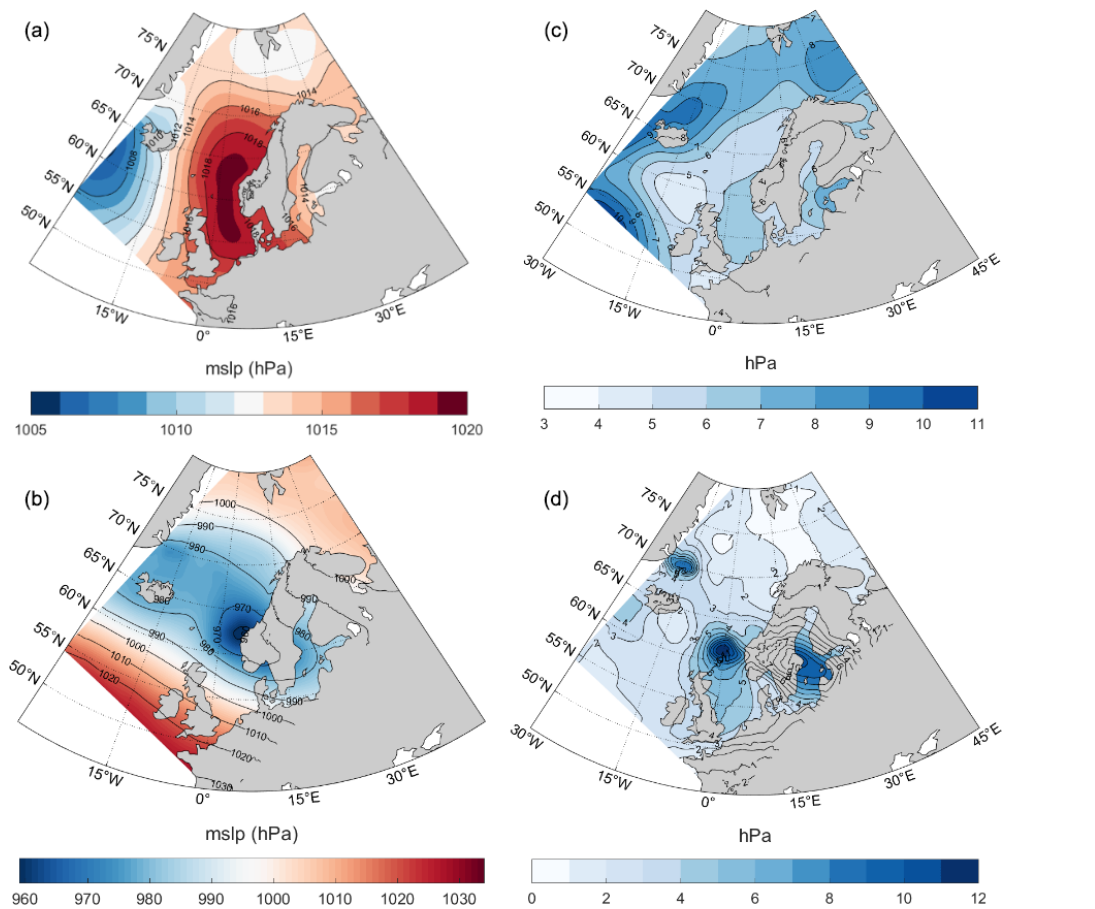
Figure 11. Average (composite mean) large-scale situations (a, b) and the corresponding standard deviations (c, d) corresponding to P c w = 0 for the site pair Ekofisk + Sleipner (ek + sl). The upper and lower rows correspond to P c w = 0 caused by too low wind ( u < 4ms − 1 ) and too high wind ( u ≥ 25ms − 1 ),